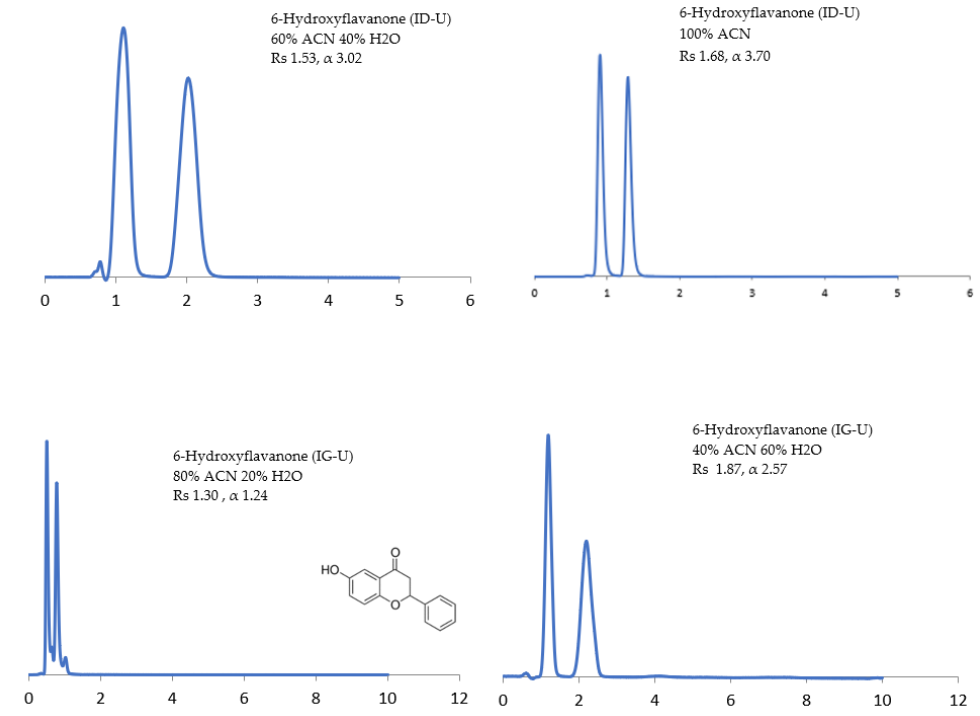
Figure 7. Enantioseparation under organic-aqueous conditions and the effect of water in acetonitrile (ACN) mobile phase on resolution (Rs) and separation factor ( α ) of 6-hydroxyflavanone. (ACN) mobile phase on resolution (Rs) and separation factor ( α ) of